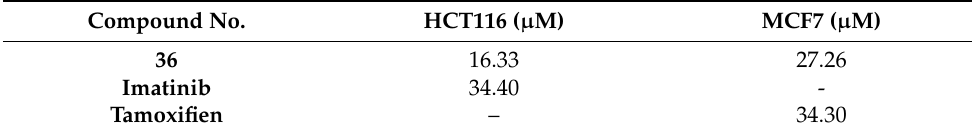
Sanchez et al. (2011) synthesized quinoline-based thiazole hybrids based on the structure of m-Amsacrine ( 37 , Figure 41), and evaluated their anticancer activity against cancerous (K-562) and non-cancerous (PMBCs) cells. Compound 37a showed excellent activity with IC 50 values of 28.7 and 7.82 µ M, respectively, compared to a control of Paclitaxel (IC 50 0.25 µ M). Mechanistically, compound 36 ( a ) induced appototic cell death via caspase activation with an IC 50 of 7.8 µ M [94].